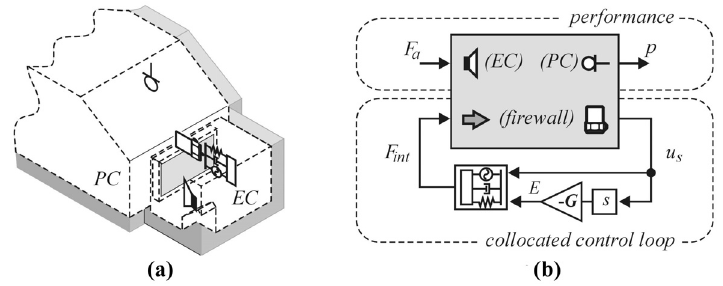
Fig. 5. Control scheme (a) positions of sensors and actuators and (b) block diagram.